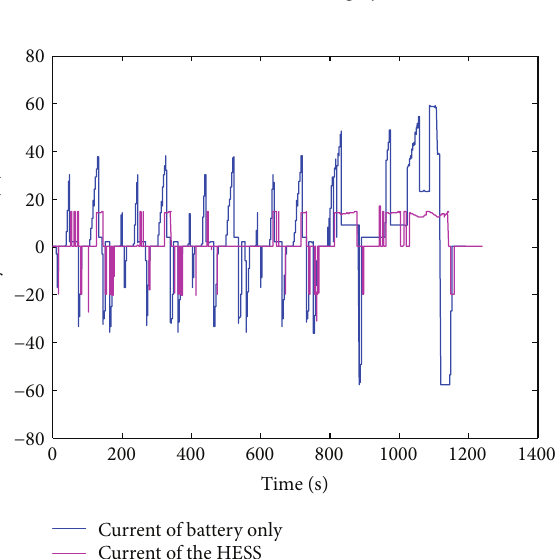
Figure 22: NEDC driving cycles.